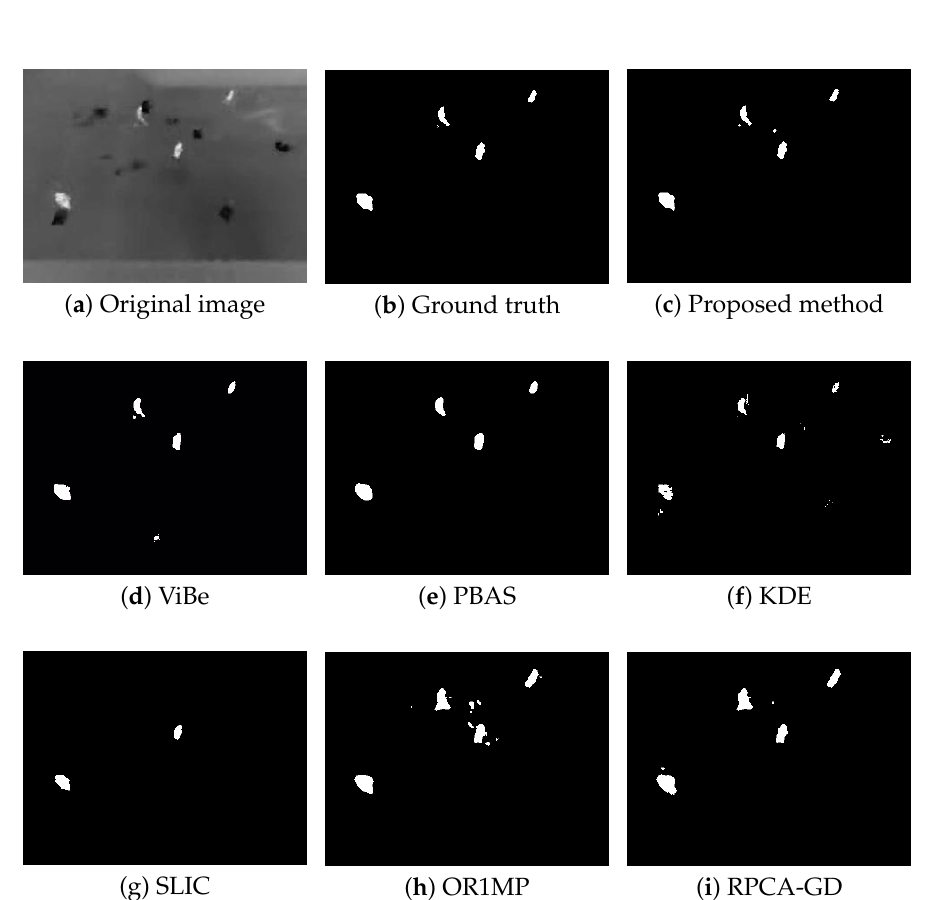
Figure 4. The detection results of the 190th frame in Seq